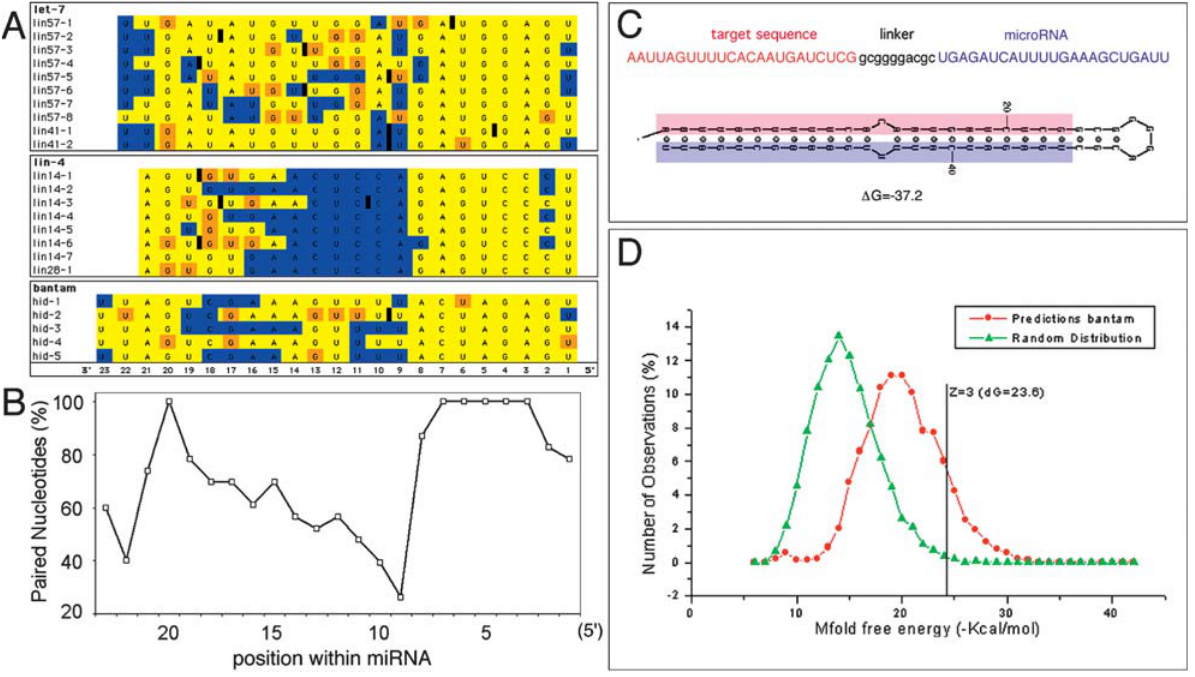
Figure 2. miRNA Target Prediction Strategy (A) let-7 , lin-4 , and bantam miRNA sequences showing the pattern of basepairing to their known targets. Yellow indicates a conventional basepair. Orange indicates a G:U basepair. Blue indicates a mismatch. The black bars indicate the positions of loops in the target sequence. Note that the extra bases that form the loops in the target sequences are not shown. Sequences are shown at the length of the miRNA. (B) Quantitation of the data from (A). This comparison shows that the 5 9 ends of the miRNA are always involved in good pairing with target sequences and suggests that searches for complementarity to the first eight residues of the miRNA would select all known targets. (C) Graphic representation of the Mfold output for the bantam miRNA and a target site from the 3 9 UTR of the hid gene . To use Mfold, it is necessary to join the predicted target site (red) and the miRNA (blue) into a single sequence using a hairpin-forming linker sequence. In this example, the target sequence and the miRNA are the same length, so the additional 5 nt in the tail of the predicted target sequence are not shown. (D) Plot of the Mfold free energy distribution for 10,000 random sequences (green) and for predicted targets of the bantam miRNA (red). X-axis: (cid:1) G calculated for each site by Mfold. DOI: